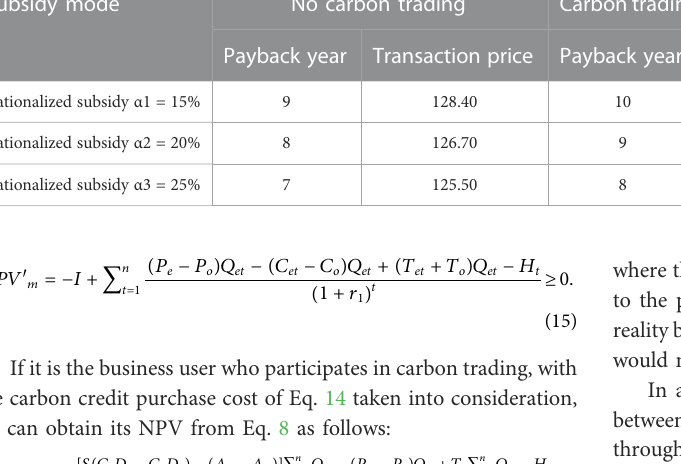
TABLE 6 Payback year and transaction price under different scenarios (thousand RMB). Subsidy